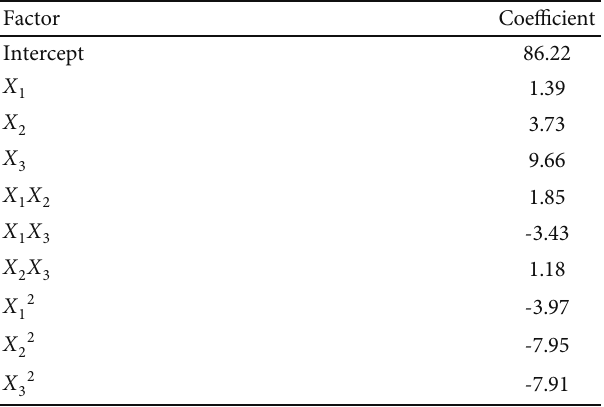
Table 7: Model coe ffi cients (Source: Design-Expert 13 Software).